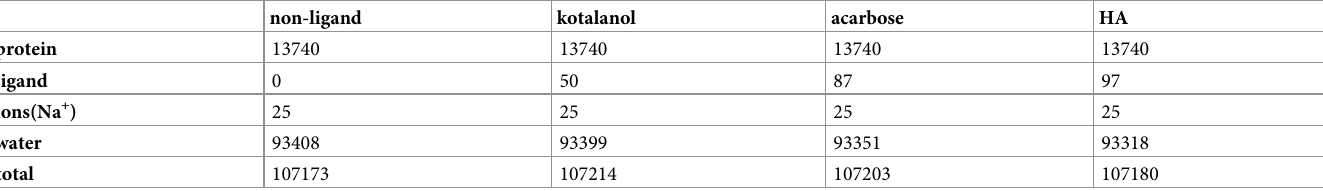
Table 1. The number of atoms in different